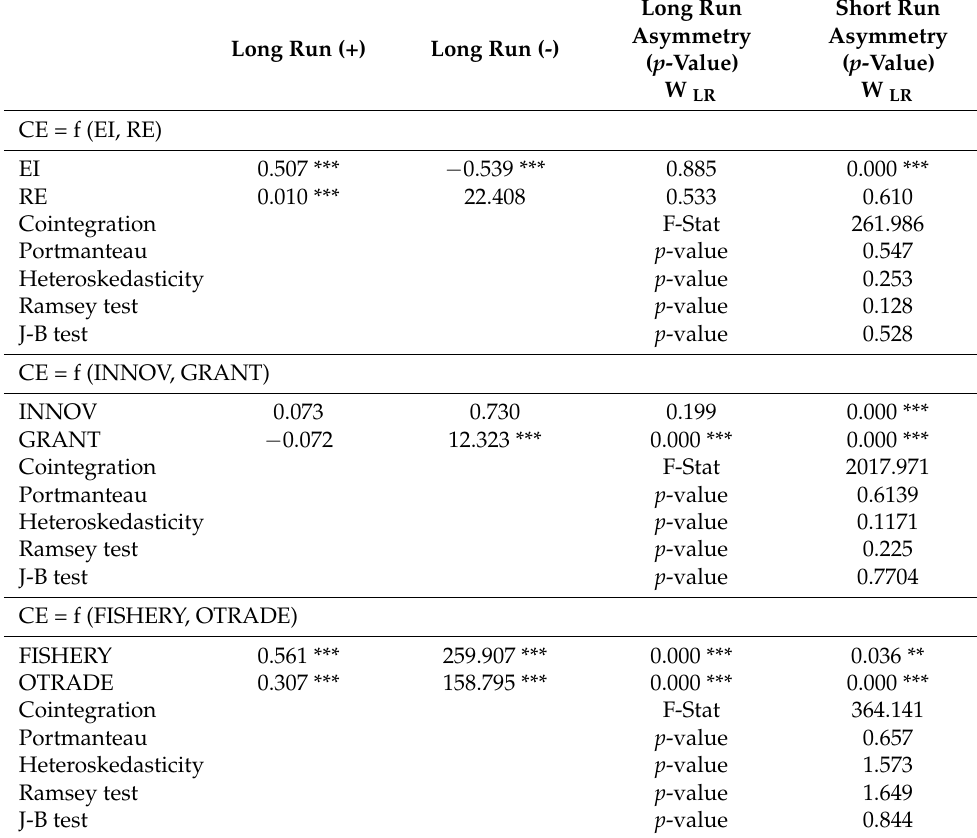
Table 12. Asymmetric and model diagnostics (after Vision